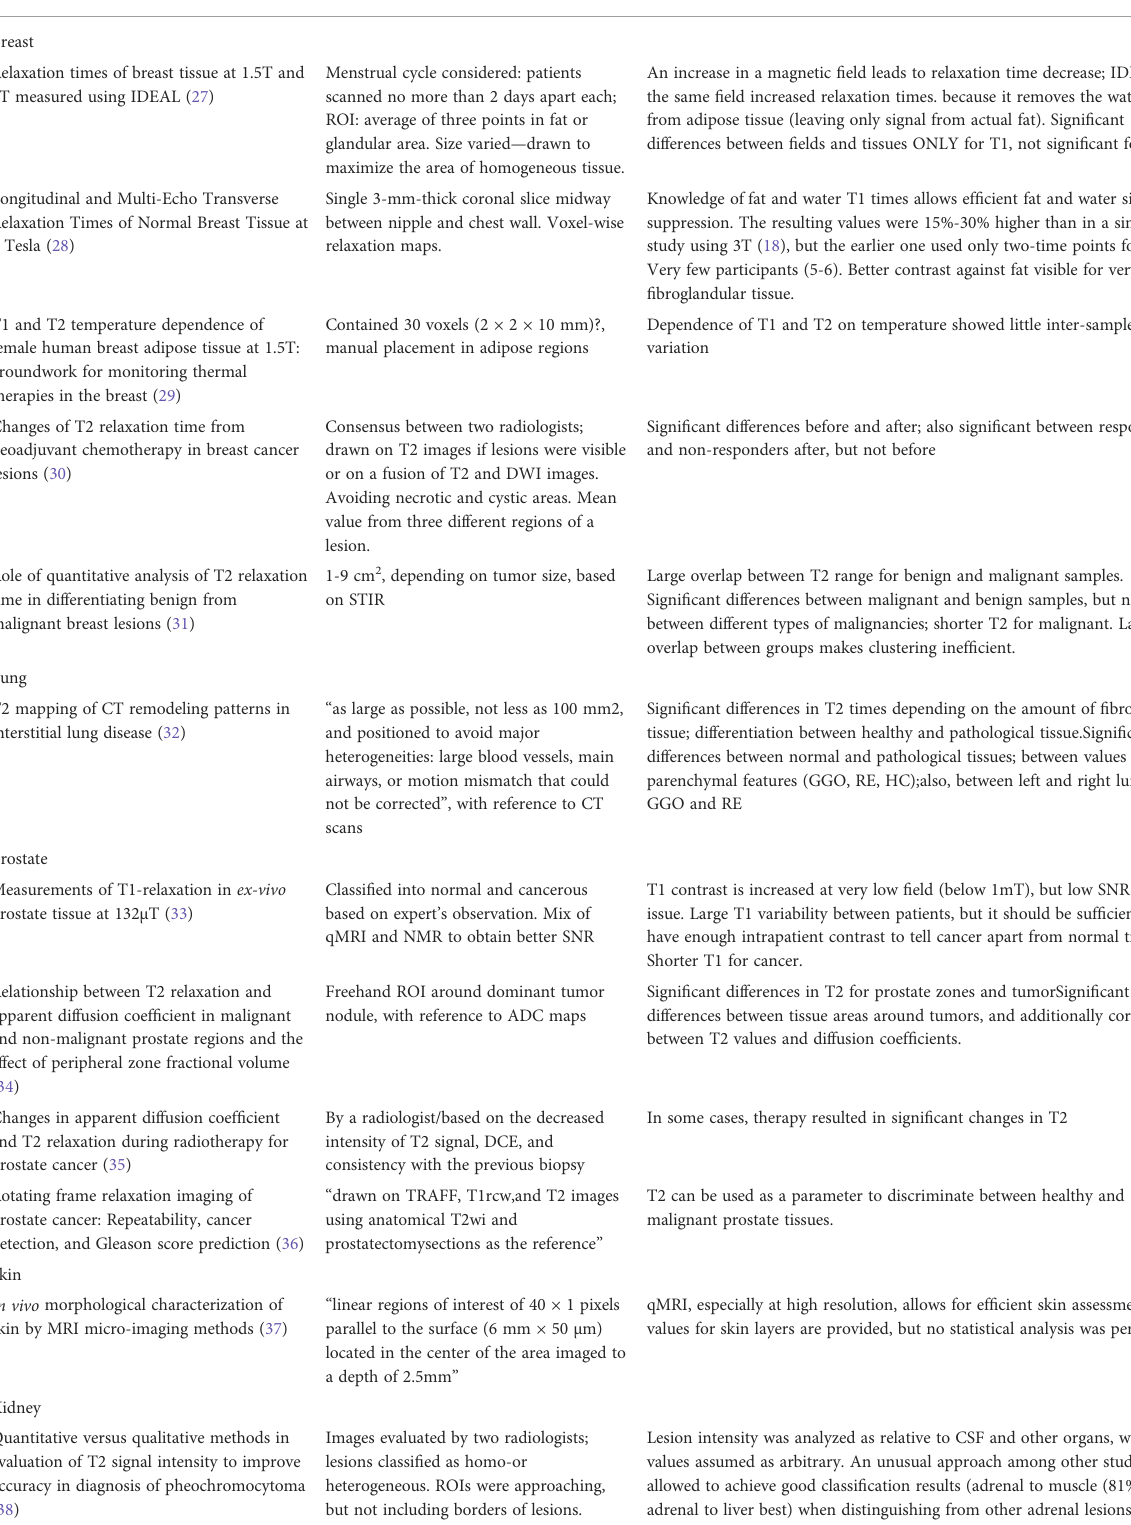
TABLE 2 Methodology and approaches to analysis in the detailed review